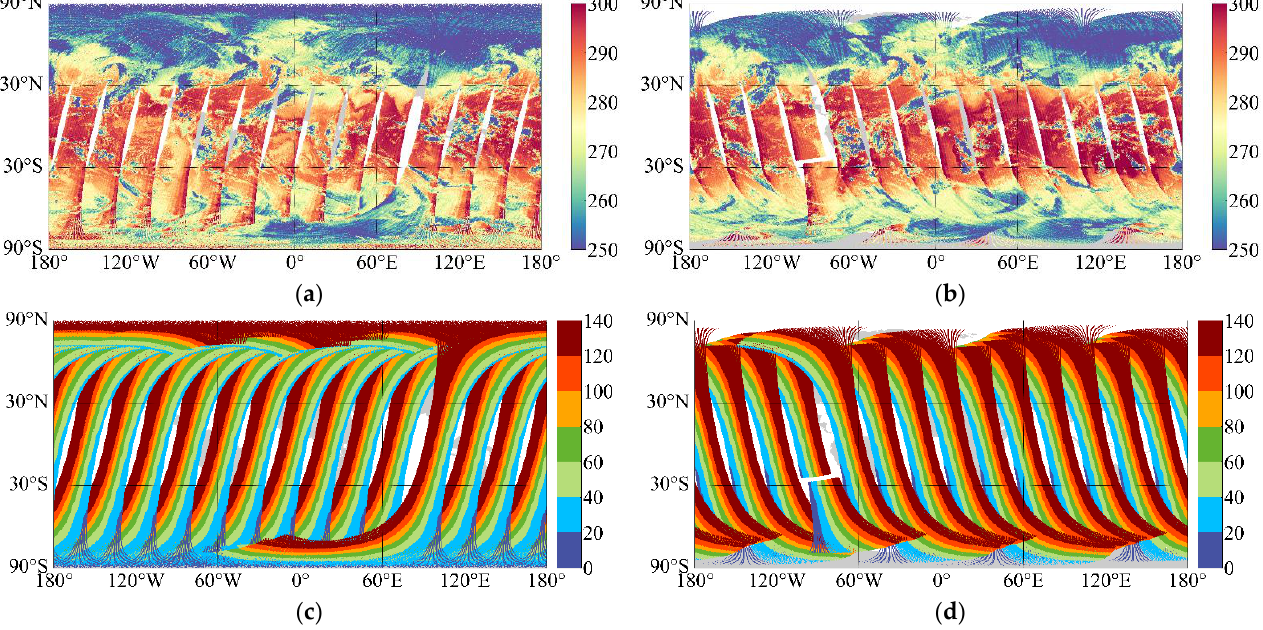
Figure 9. ( a , b ) are the brightness temperature values of the ascending orbit and descending orbit of 2500 cm −1 , respectively; ( c , d ) show the global distribution of sun glint angles for the ascending and descending orbits of HIRAS-II, respectively.